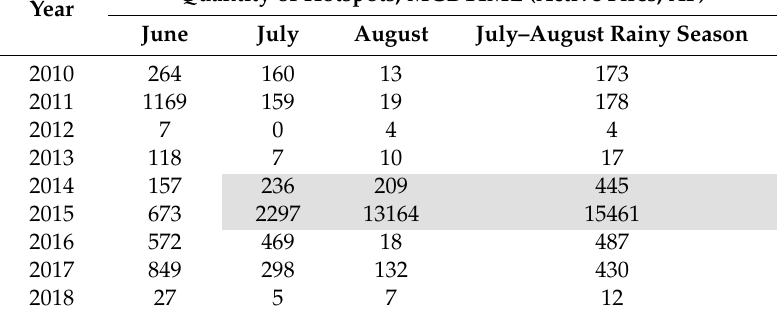
Table 2. The number of MCD12ML hotspots (active fires, AF), established with more than 75% confidence located in the Russian part of the Baikal basin, during the climatic dry period (June) and climatic wet period (July–August). The abnormal increase in wildfire amount in the climatic wet period is highlighted by gray